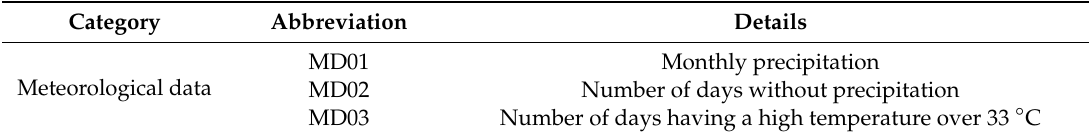
Table 1. Meteorological data details and